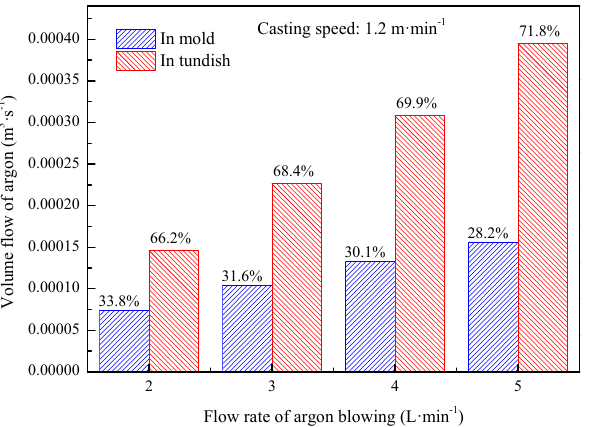
Figure 9. Volume flow distribution of argon under different argon flow rate.